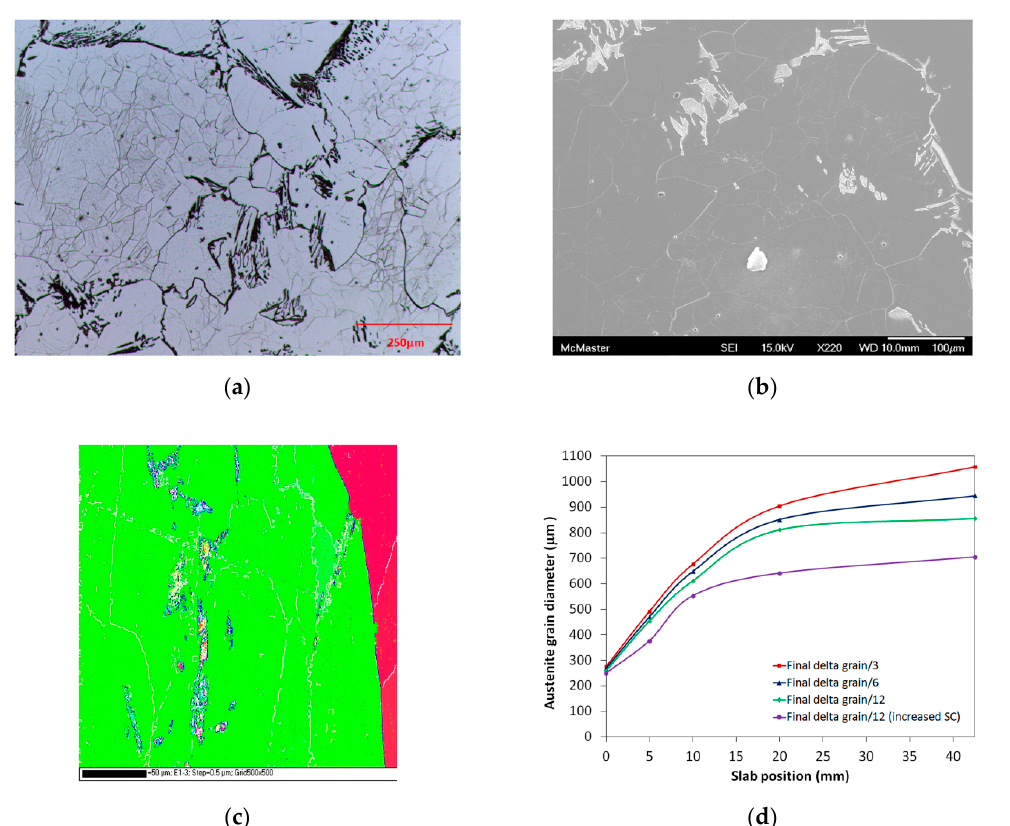
Figure 12. Microstructure of model Fe-Al alloy reheated into the delta region for 60 s, a compressive strain of 0.2 was applied followed by cooling at 50 °C/s to 1125 °C; the sample was quenched to room temperature as soon as it reached 1125 °C: ( a ) Fine sub-grains present within the original delta-ferrite grains; ( b ) austenite nucleates along the original delta grain boundaries; ( c ) electron backscatter diffraction (EBSD) shows austenite grains nucleated along the delta grain and sub-grain boundaries, and ( d ) predicted austenite grain size when the slab is about to enter the homogenization furnace, with different austenite nucleation sites.